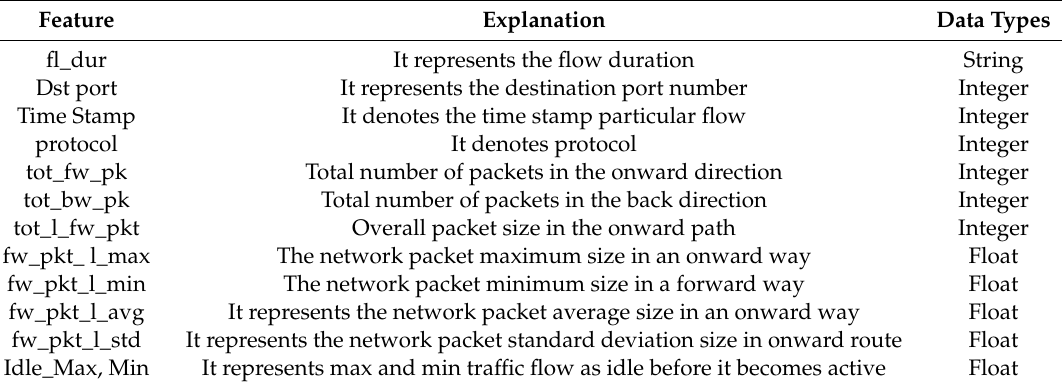
Table 5. List of CSE-CIC-IDS2018 extracted features via